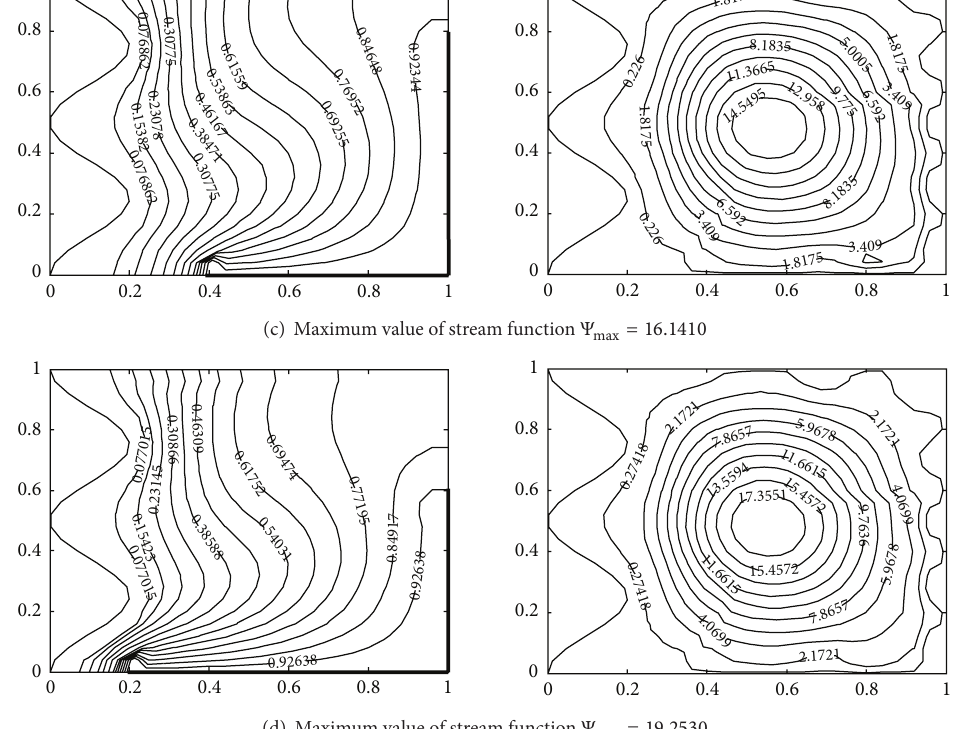
(d) Maximum value of stream function Ψ max = 19.2530 Figure 7: Temperature contours (on the left) and streamlines (on the right) with different heater length at Ra = 10 5 , Pr = 0.7 , 𝐴 = 0.2 , 𝑛 = 2 , (a) ℎ𝑥 = 0.6 , ℎ𝑦 = 0.4 , (b) ℎ𝑥 = 0.6 , ℎ𝑦 = 0.6 , (c) ℎ𝑥 = 0.6 , ℎ𝑦 = 0.8 , and (d) ℎ𝑥 = 0.8 , ℎ𝑦 = 0.6